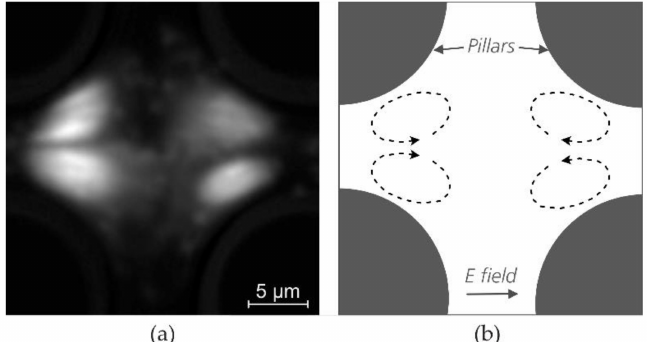
Figure 9. Vortices of 1.1 µ m polystyrene beads in milliQ water at 500 V PP at 100 Hz, in device #4 ( G = 8 µ m, distance between electrodes ≈ 7 mm). ( a ) Actual image, ( b ) Diagram showing the direction of the vortices). The original image stack ( 557 frames @25fps) has the field of view of 8 × 7 identical unit cells (the image shows one unit cell). To simultaneously observe the dynamics of many particles, we used MATLAB 2017a (Mathworks, Natick, MA, USA) to superimpose all these unit cells into one unit cell. The resulted image stack was then averaged to produce the image shown in the figure.